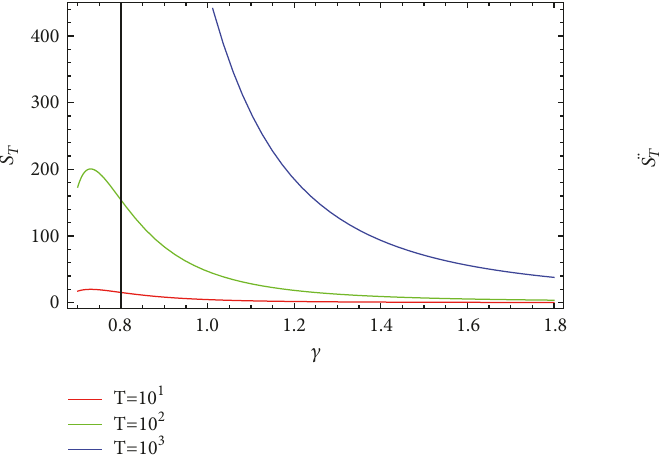
̈𝑆 𝛾 for Bekenstein entropy when Γ is 𝑇 versus